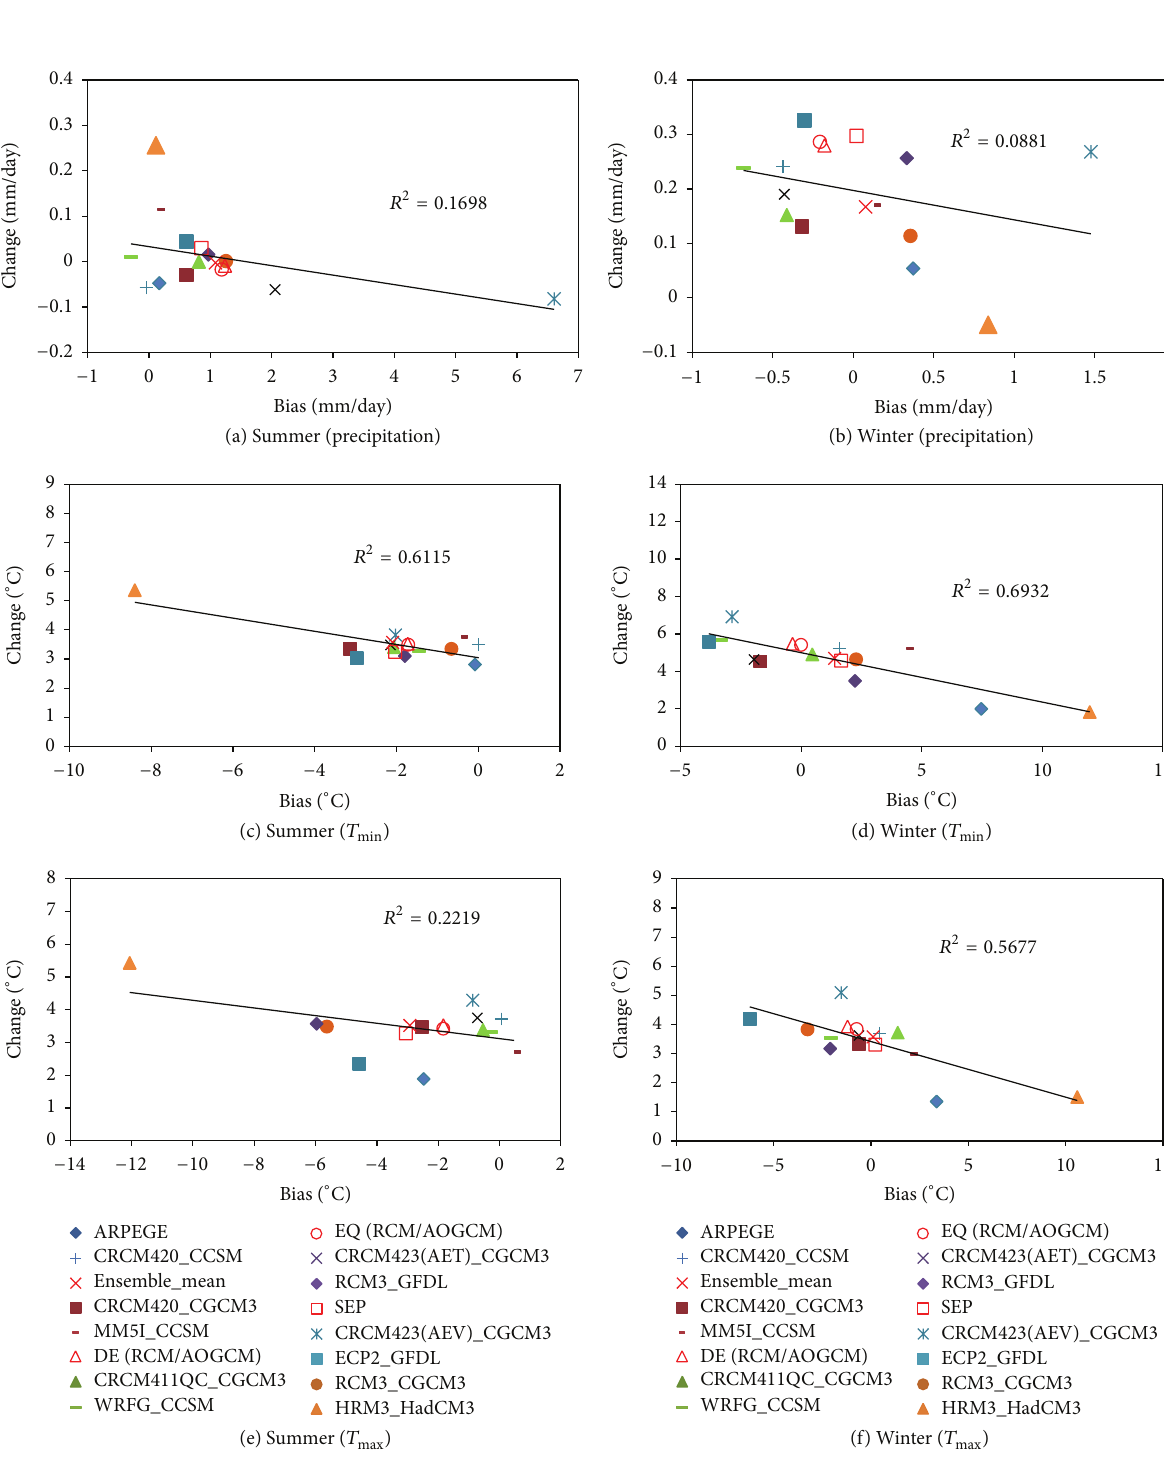
Figure 4: Seasonal (summer and winter, left and right panels, resp.) scatter plots of intermodel and synthetic data of mean change ( 𝑦 -axis) versus bias ( 𝑥 -axis) for the mean precipitation ((a) and (b) panels) and the minimum ((c) and (d) panels) and maximum ((e) and (f) panels) temperatures: all values are spatially averaged over the study